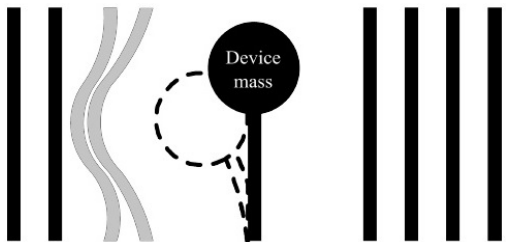
Figure 14. Nonlinear compliant beams mitigate kinetic energy through bending when struck by a proof mass.